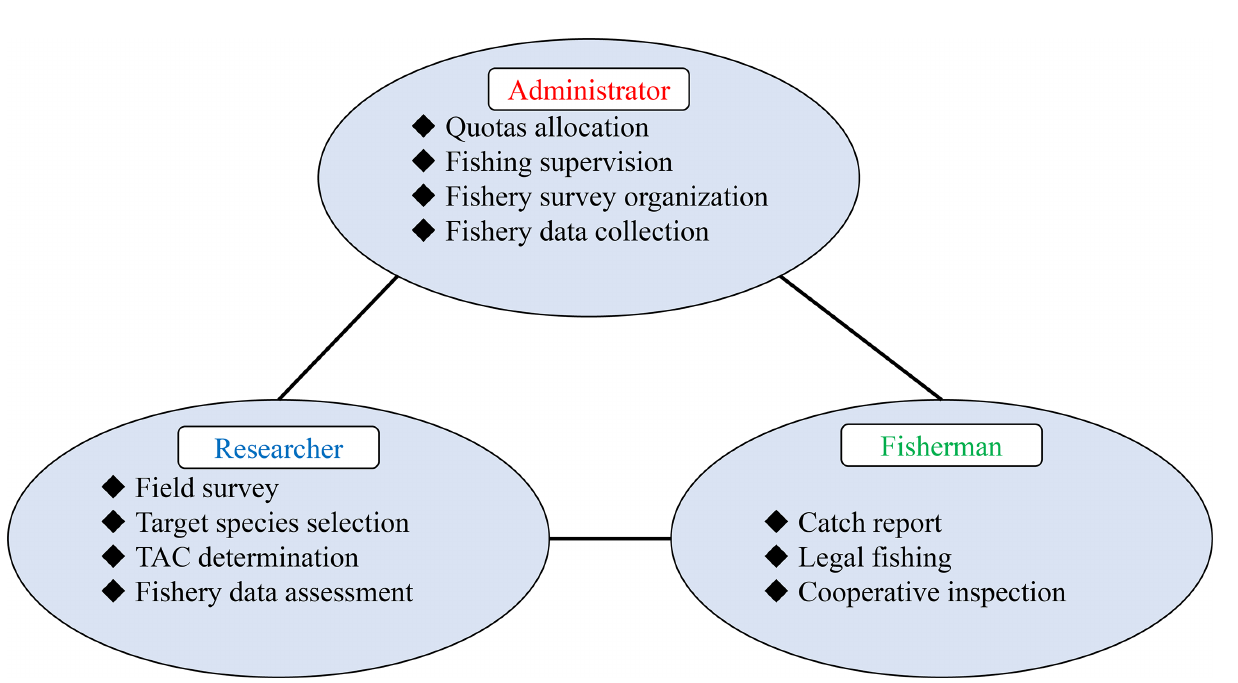
FIGURE 5 | The respective responsibilities of administrators, researchers, and fi shermen under the FQ